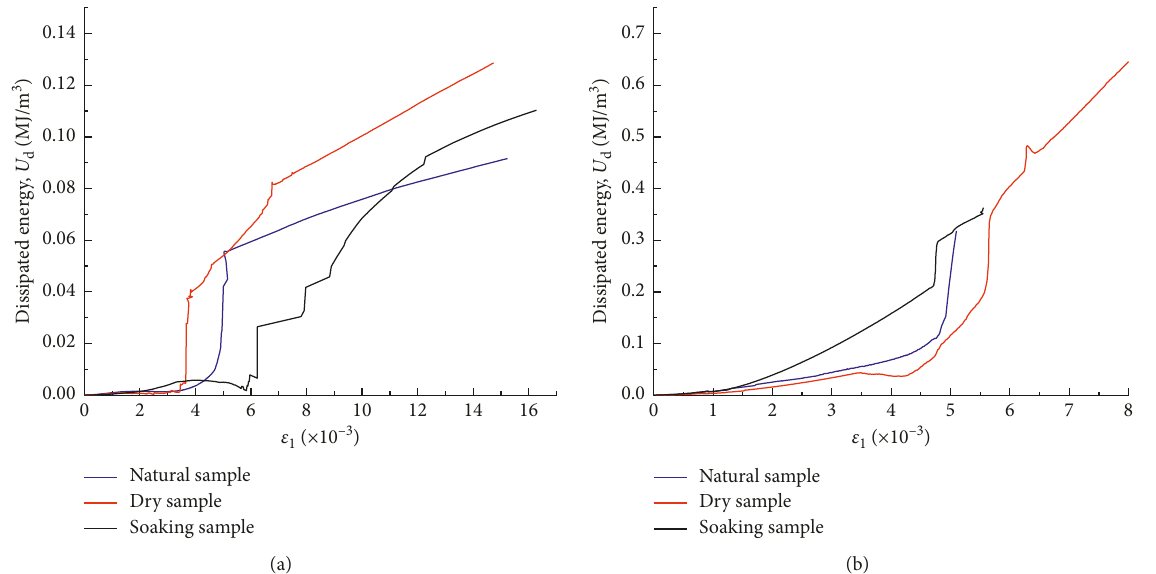
Figure 6: Relation curves of dissipated energy with strain under different confining pressures. (a) 0MPa. (b) 30MPa.